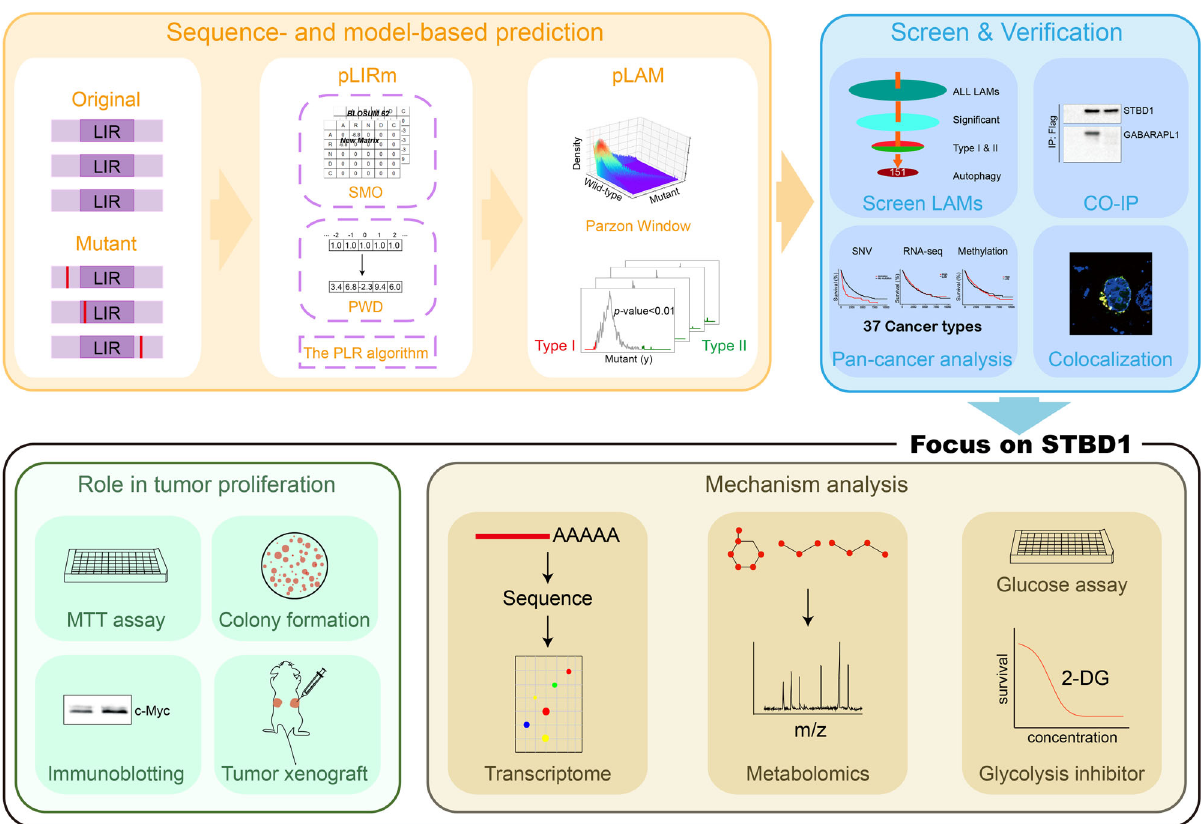
Fig. 1 Major steps of iCAL. i Design a sequence-based predictor, pLIRm, and develop a model-based approach, pLAM; ii computational prioritization of potential LAMs that signi fi cantly in fl uence cLIR motifs, and then pan-cancer analysis and experimental validation of predicted LAM-containing LIRCPs; iii combine transcriptomics, metabolomics with additional experimental assays to study the role and mechanism of STBD1 in tumor proliferation; Co-IP co-